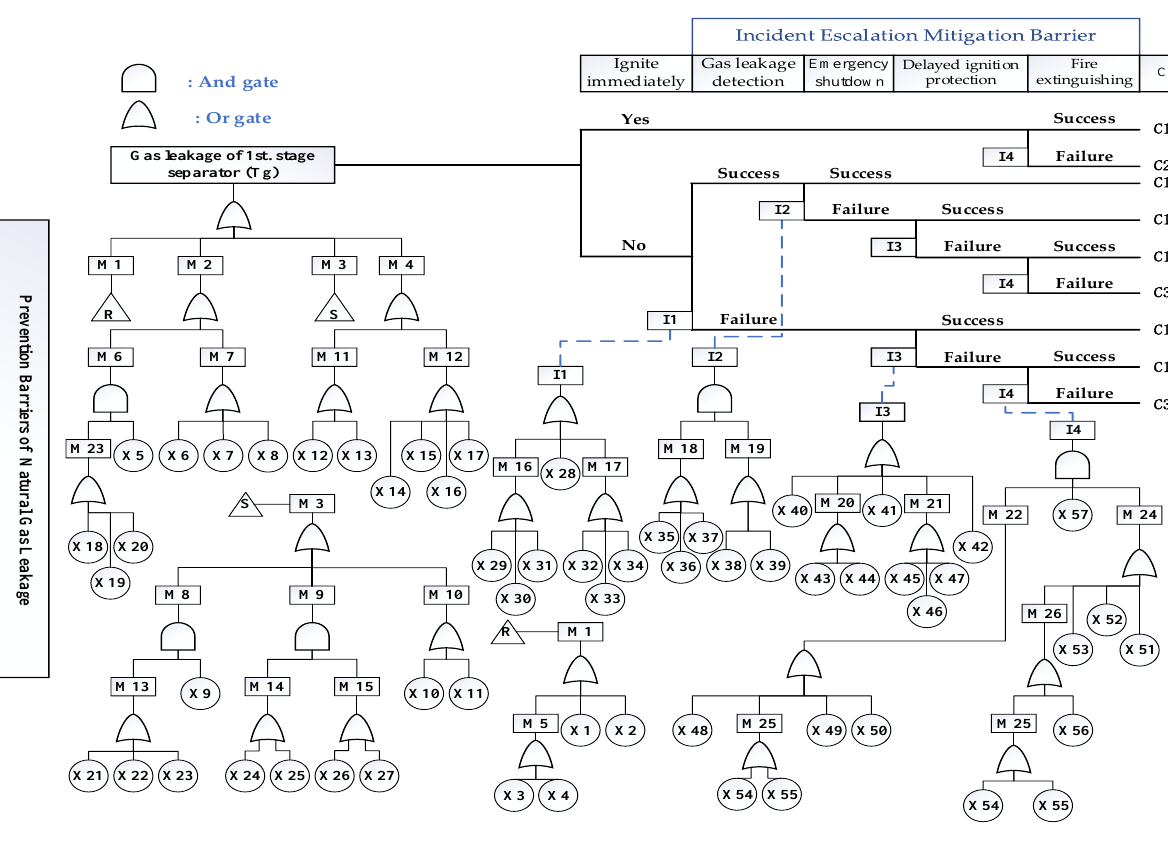
Figure 7. The BT model of oil leakage. “ X ” , “ M ” , and “ T ” constitute the basic events, intermediate events, and top events of FTA, respectively. I1 – I5 represent control and mitigation barriers in ETA, and C1 – C6 represent accident consequences. The basic event symbol description is shown in Table